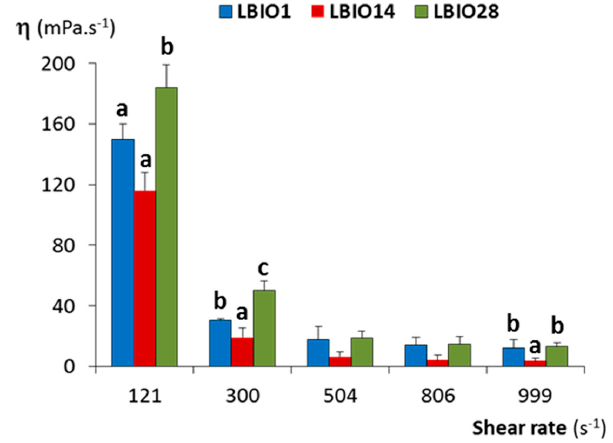
Figure 4. Dynamic viscosity ( η ) at different shear rates of stirred fermented milks obtained after fermentation for 24 h of skim-milk with the EPS-producing strains L. plantarum LBIO1, LBIO14 or LBIO28. Within each shear rate, bars that do not share a common letter are significantly different according to analysis of variance (ANOVA) and Student–Newman–Keuls (SNK) ( p < 0.05) mean comparison test.